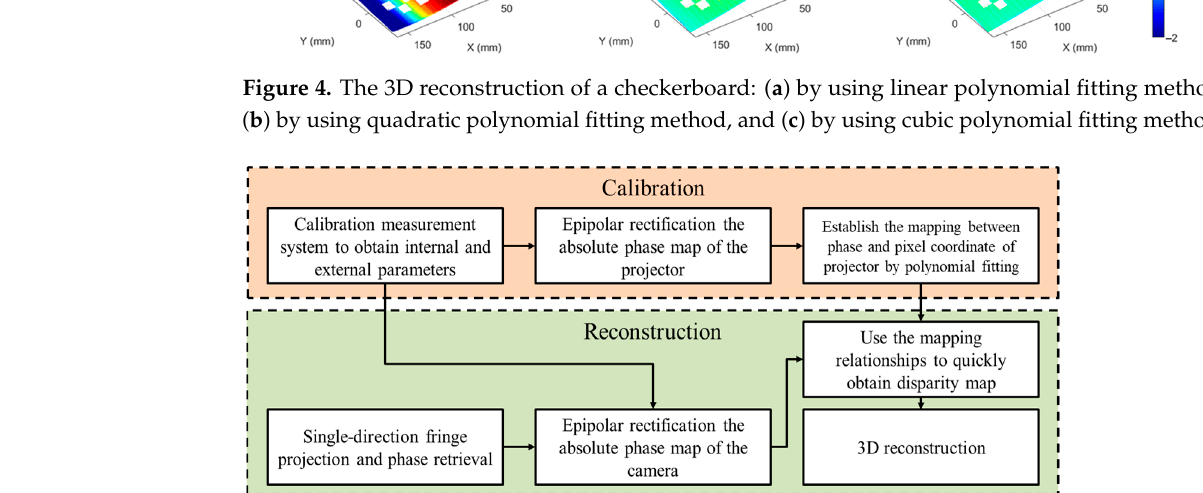
Figure 5. The overall flow chart of the proposed method.